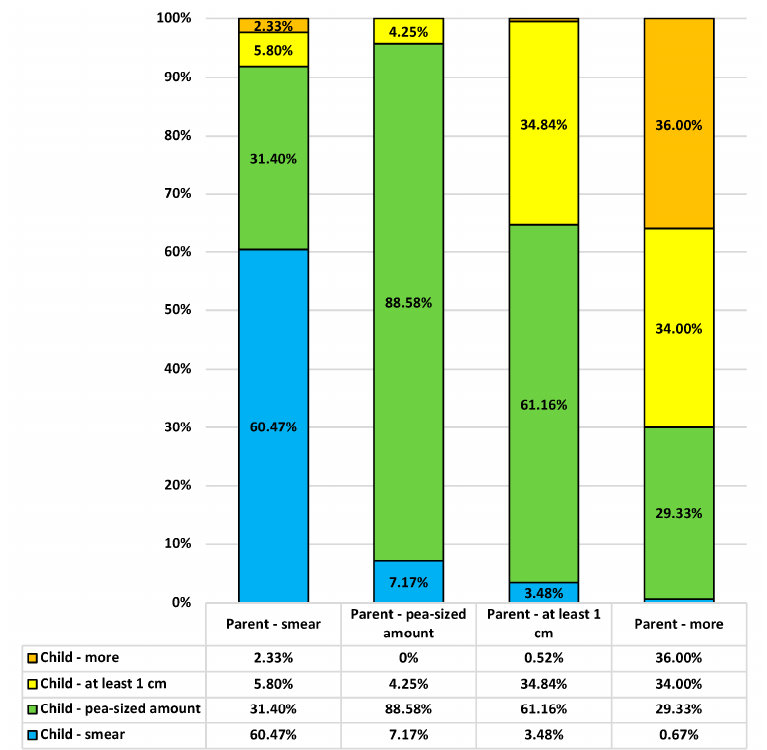
Figure 2. The amounts of toothpaste used: parents vs. their children.